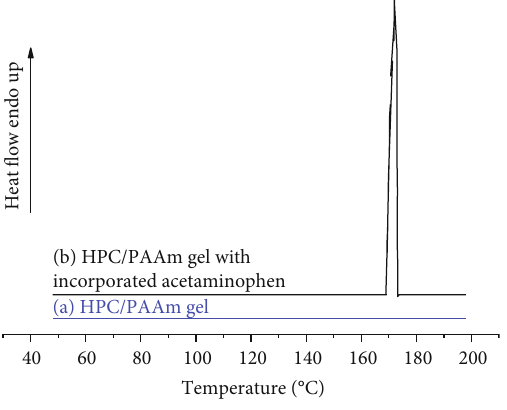
Figure 5: Thermograms of (a) HPC/PAAm gel and (b) HPC/PAAm gel with incorporated